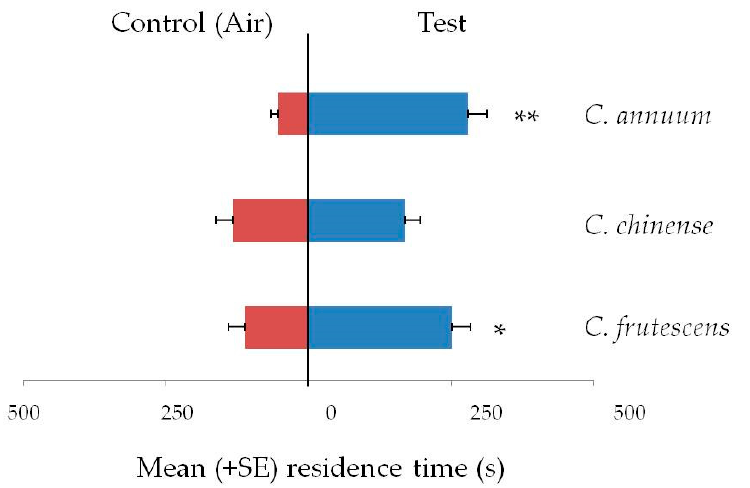
Figure 1. Olfactory response of Lasioderma serricorne to volatiles of dried fruit powder of three Capsicum species , C. annuum , C. chinense and C. frutescens , in Y-tube olfactometer. Bars indicate the mean residence time (+SE) adult beetles spent in the arm with the odor source. Thirty insects tested per treatment. T-test for dependent samples, * p < 0.05 ** p < 0.01.